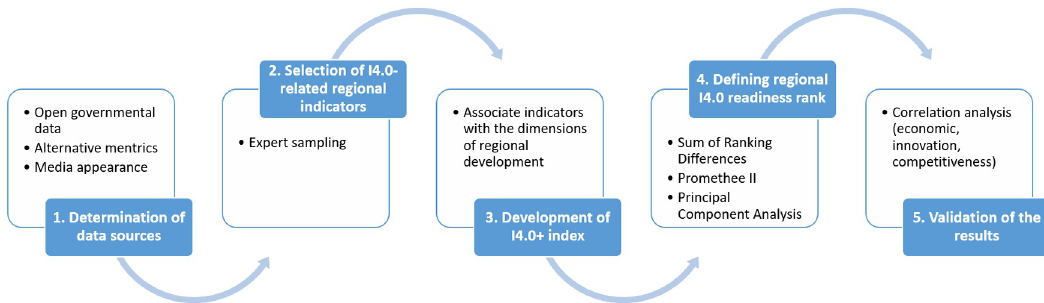
Fig 3. The methodological workflow of developing and analysing the I4.0+ readiness